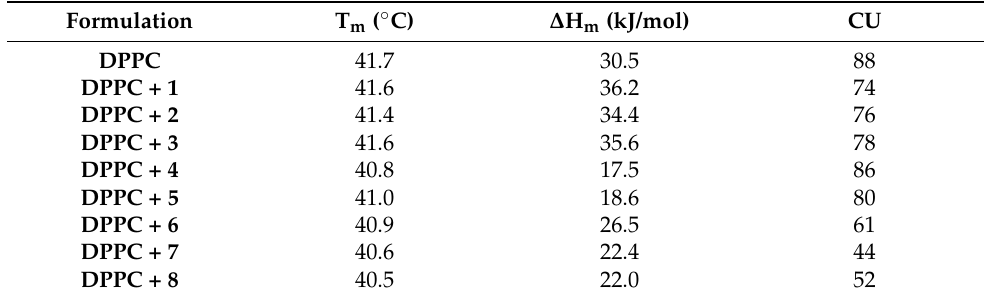
Table 2. Thermodynamic parameters obtained by DSC measurements on DPPC multilamellar vesicles, including quinolines 1–8 . Uncertainties are ± 0.1 ◦ C in temperatures and ± 0.5 kJ/mol in ∆ H m values.